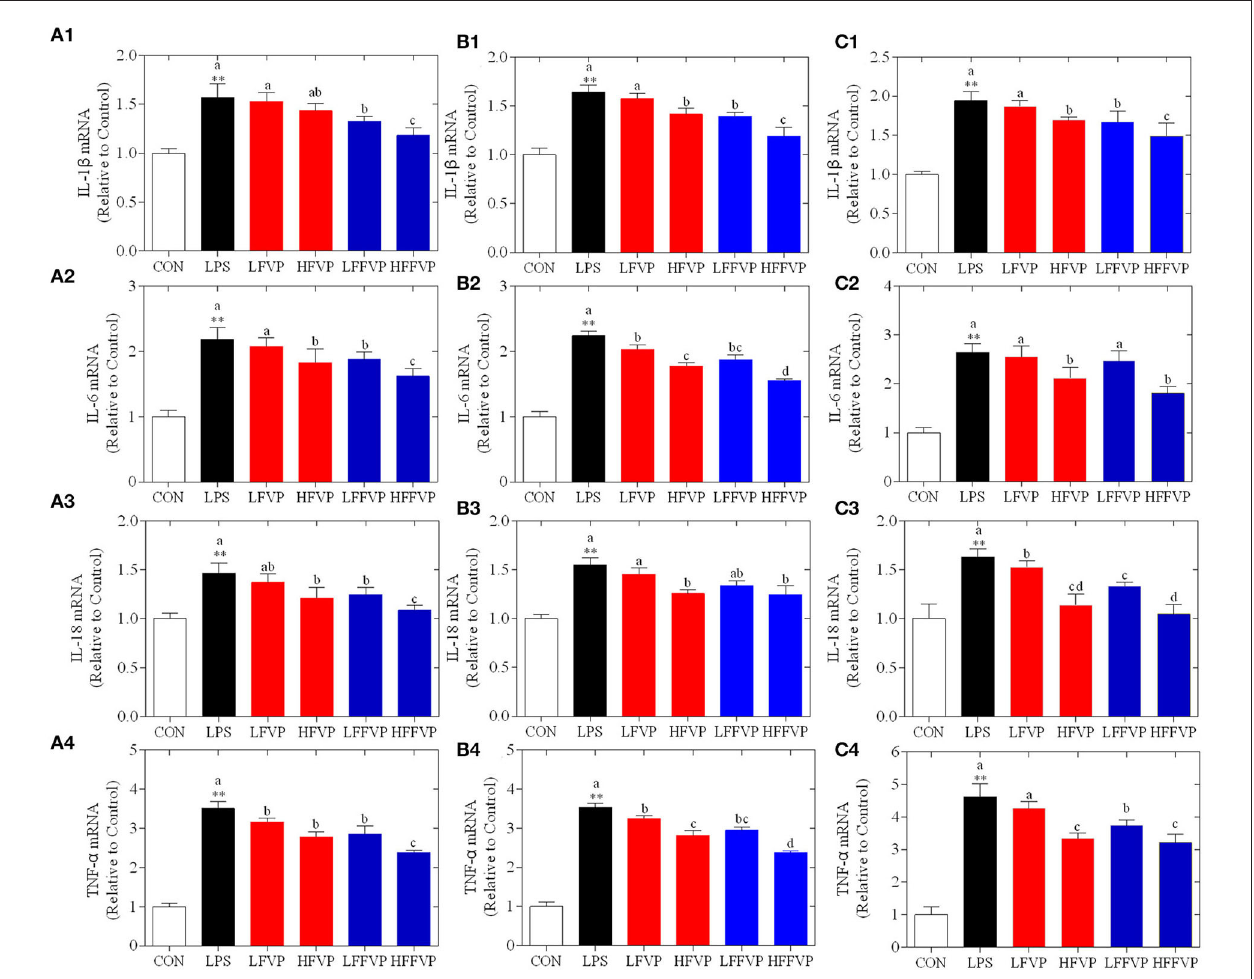
FIGURE 4 | LPS-induced IL-1 β (1), IL-6 (2), IL-18 (3) and TNF- α (4) mRNA expression treated by FVP and FFVP in jejunum (A) , ileum (B) , and colon (C) . Mice were stimulated with 3 mg/kg LPS and/or 50 and 100 mg/kg FVP and FFVP. CON group, LPS group (3 mg/kg LPS), FVP and FFVP groups (50/100 mg/kg FVP and FFVP plus 3 mg/kg LPS). FV, Flammulina velutipes ; FVP, Flammulina velutipes polysaccharides; CON, control group; LPS, lipopolysaccharide; LFVP, low dose FVP group; HFVP, high dose FVP group; LFFVP, low dose FFVP group; HFFVP, high dose FFVP group. ** P < 0.01 represents LPS vs. CON group; a, b and c ( P < 0.05) represent FVP and FFVP groups vs. LPS treated